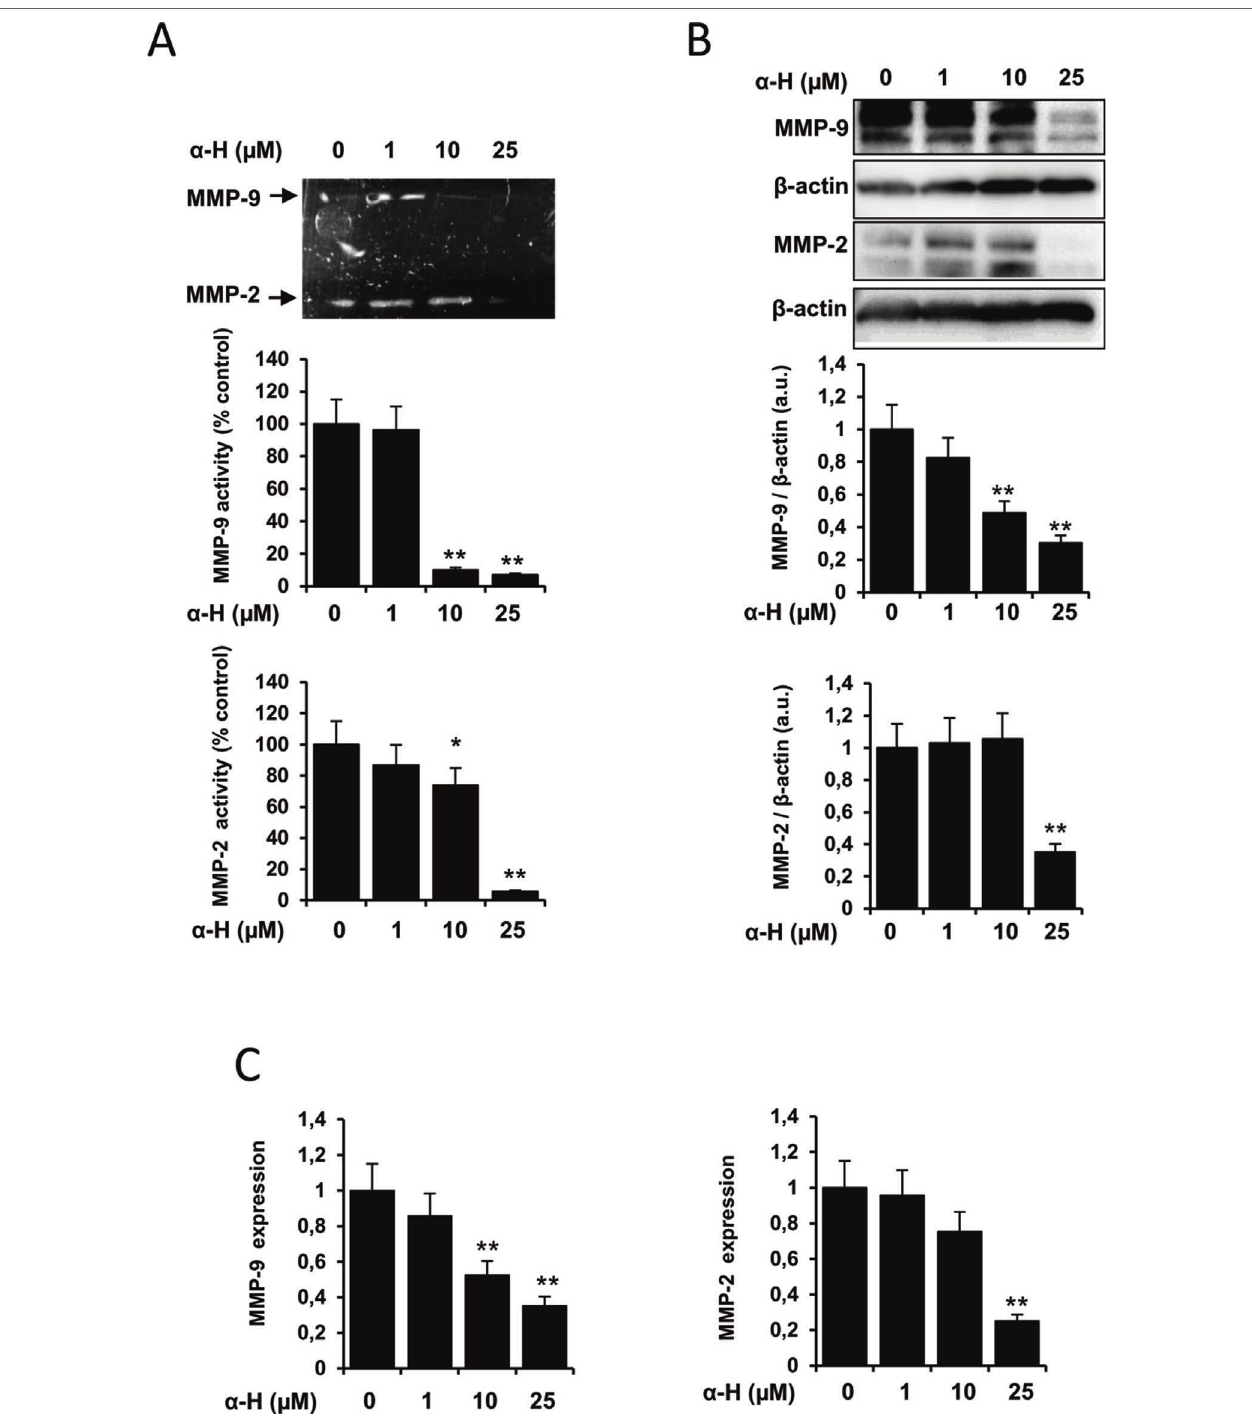
FIGURE 5 | α -H inhibited the expression and activity of MMP-2 and MMP-9. U87 cells were treated with different concentrations of α -H (1, 10, and 25 μM) or vehicle as control for 24 h. (A) Conditioned medium was collected, and the activities of MMP-2 and MMP-9 were determined by gelatin zymography assay. A representative experiment is shown of three performed. Bars graphs show densitometry quantification of the bands and represent mean percentage of MMPs activities ± S.D. from three independent experiments. *P < 0.05 and **P < 0.01 with respect to the non-treated cells. (B) MMP-2 and MMP-9 protein levels were determined by Western blot. β -actin was used as loading control. A representative experiment is shown of three performed. Bars graphs show densitometry quantification of the bands and represent means MMPs/ β -actin ratio ± S.D. from three independent experiments. *P < 0.05 and **P < 0.01 with respect to the non-treated cells. (C) mRNA expression of MMP-2 and MMP-9 was determined by quantitative PCR. Values represent the means ± S.D. of three independent experiments performed in triplicate. *P < 0.05 and **P < 0.01 with respect to the non-treated